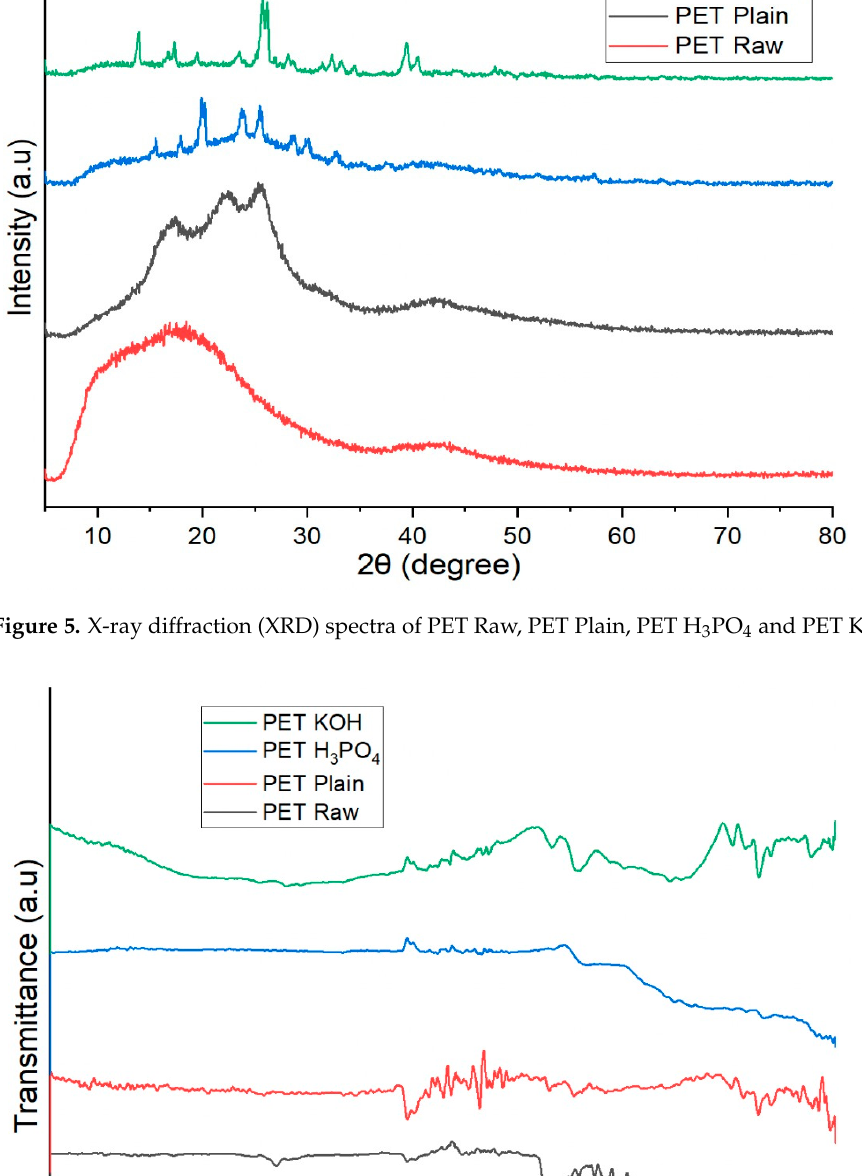
Figure 6. FTIR spectra of PET Raw, PET Plain, PET H 3 PO 4 and PET